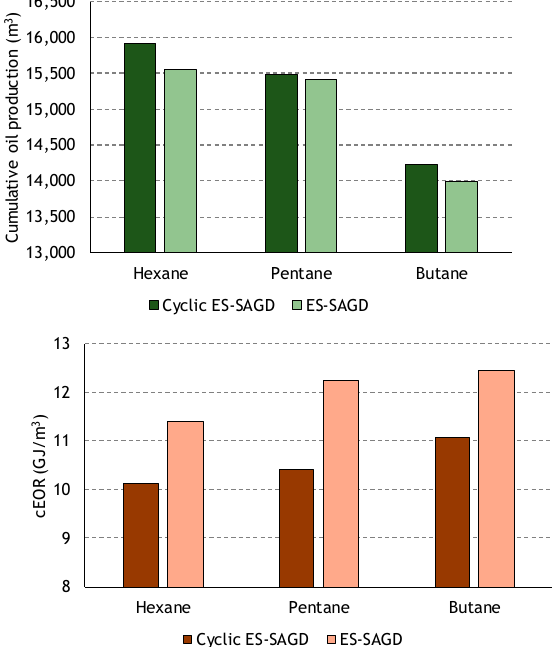
Figure 19. Comparison in terms of cEOR and cumulative oil production for cyclic ES-SAGD and ES-SAGD cases using hexane, pentane, and butane.